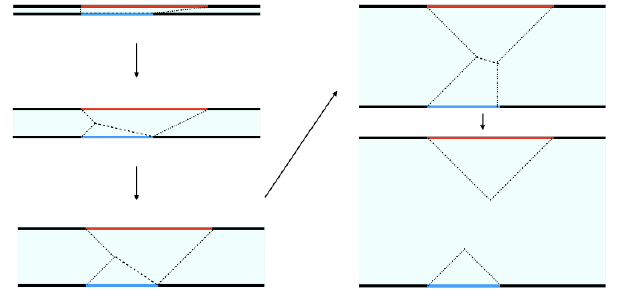
Figure 2 . The cartoon shows the time evolution of the minimal membrane for operator mutual information (dotted lines) and operator logarithmic negativity (dashed lines) between input (blue) and output (red) (cid:12)nite intervals. In the connected regime, the membrane connecting the left ends of the intervals grows linearly, displaying the leaking of quantum information. The length of the minimal cross-section decreases linearly, showing the same leaking. The length of the right membrane remains constant for the (cid:12)rst three time steps as the slope remains above 1; after, the length grows linearly. Similarly, the length of the minimal cross-section decreases at twice the speed after the slope decreases below 1. This demonstrates causality in that the quantum information cannot leak out the right side until the endpoints are time-like separated. At late times, the membrane reaches the disconnected regime where the BOMI and BOLN are manifestly trivial (bottom